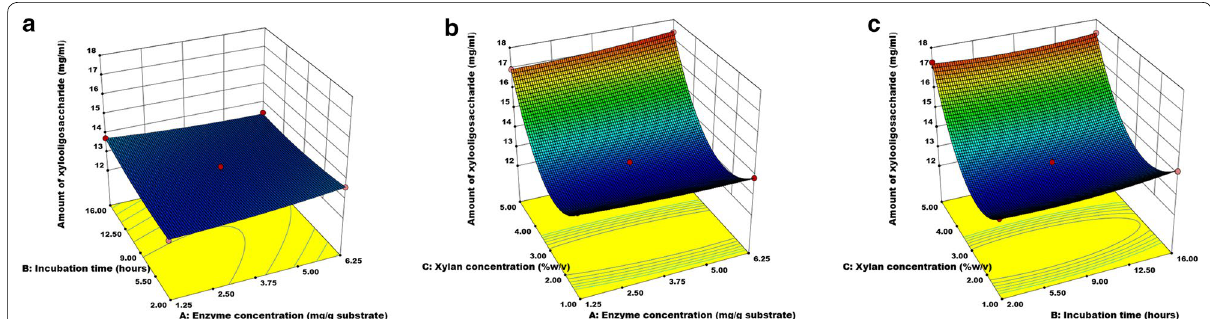
Fig. 3 Response surface plot for enzyme hydrolysis of xylan describing the interaction of independent variables such as enzyme concentration, xylan concentration, and incubation time. a Effect of enzyme concentration and incubation time, b effect of enzyme concentration and xylan concentration, and c effect of incubation time and xylan